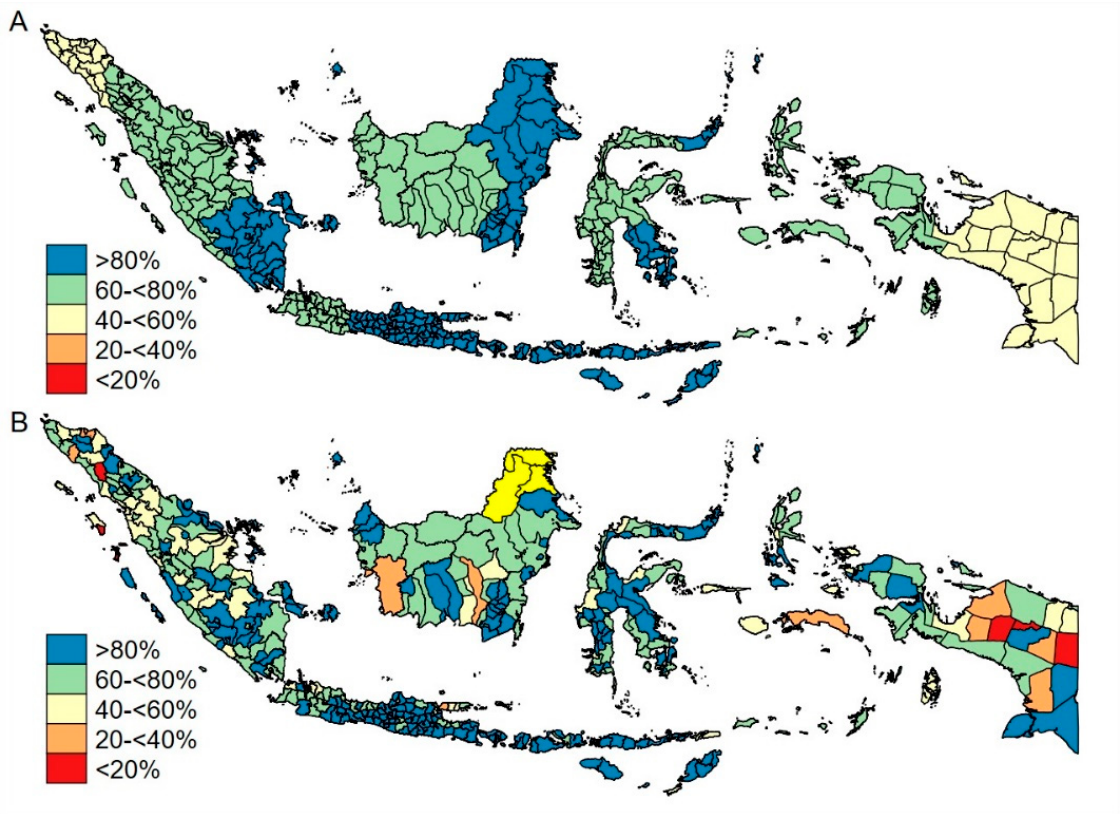
Figure 2. Spatial distribution of DTP3 immunization coverage by ( A ) provinces and ( B ) districts (2016).